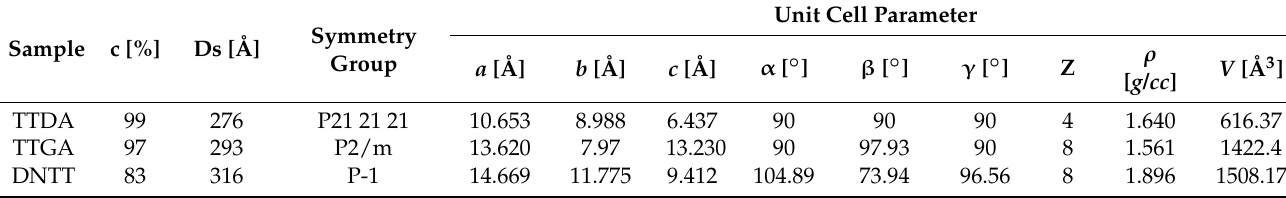
Table 3. Crystal structure of energetic compounds.